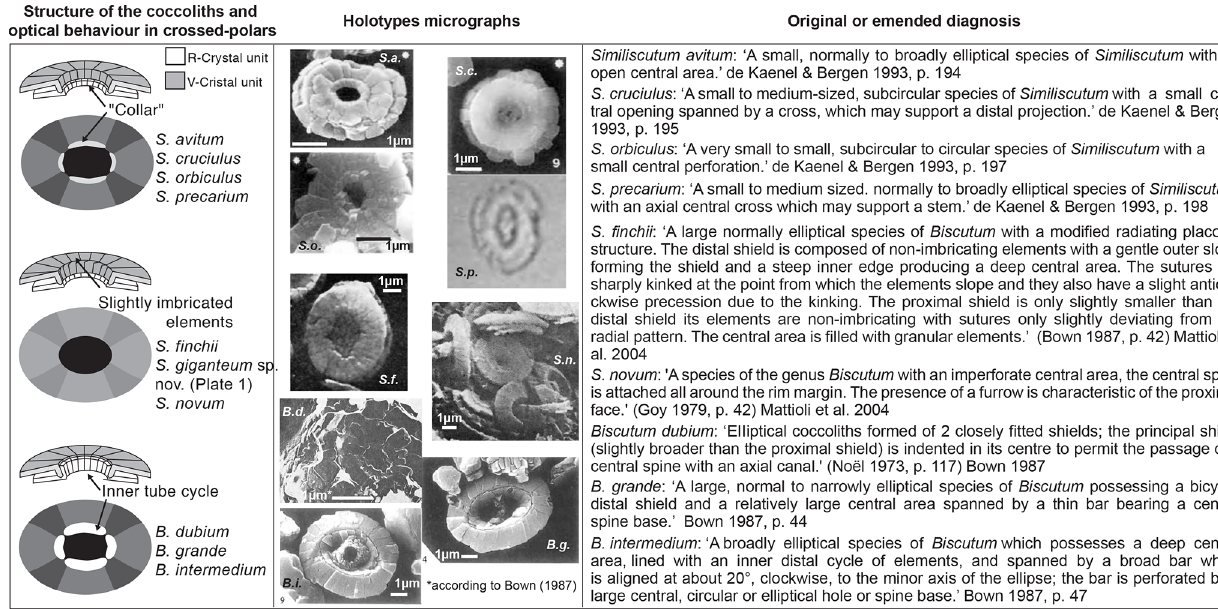
Figure 5. In order to effectively compare Similiscutum giganteum sp. nov. to other Lower Jurassic Biscutaceae, the simplified structure in op- tical microscopes and SEMs (left column), the holotype micrographs (middle column), and the original or emended diagnoses (right column) are reported. An explanation of abbreviations is as follows: S.a. = Similiscutum avitum ; S.c. = Similiscutum cruciulus ; S.o. = Similiscutum orbiculus ; S.p. = Similiscutum precarium ; S.f. = Similiscutum finchii ; S.n. = Similiscutum novum ; B.d. = Biscutum dubium ; B.g. = Biscutum grande ; B.i. = Biscutum intermedium